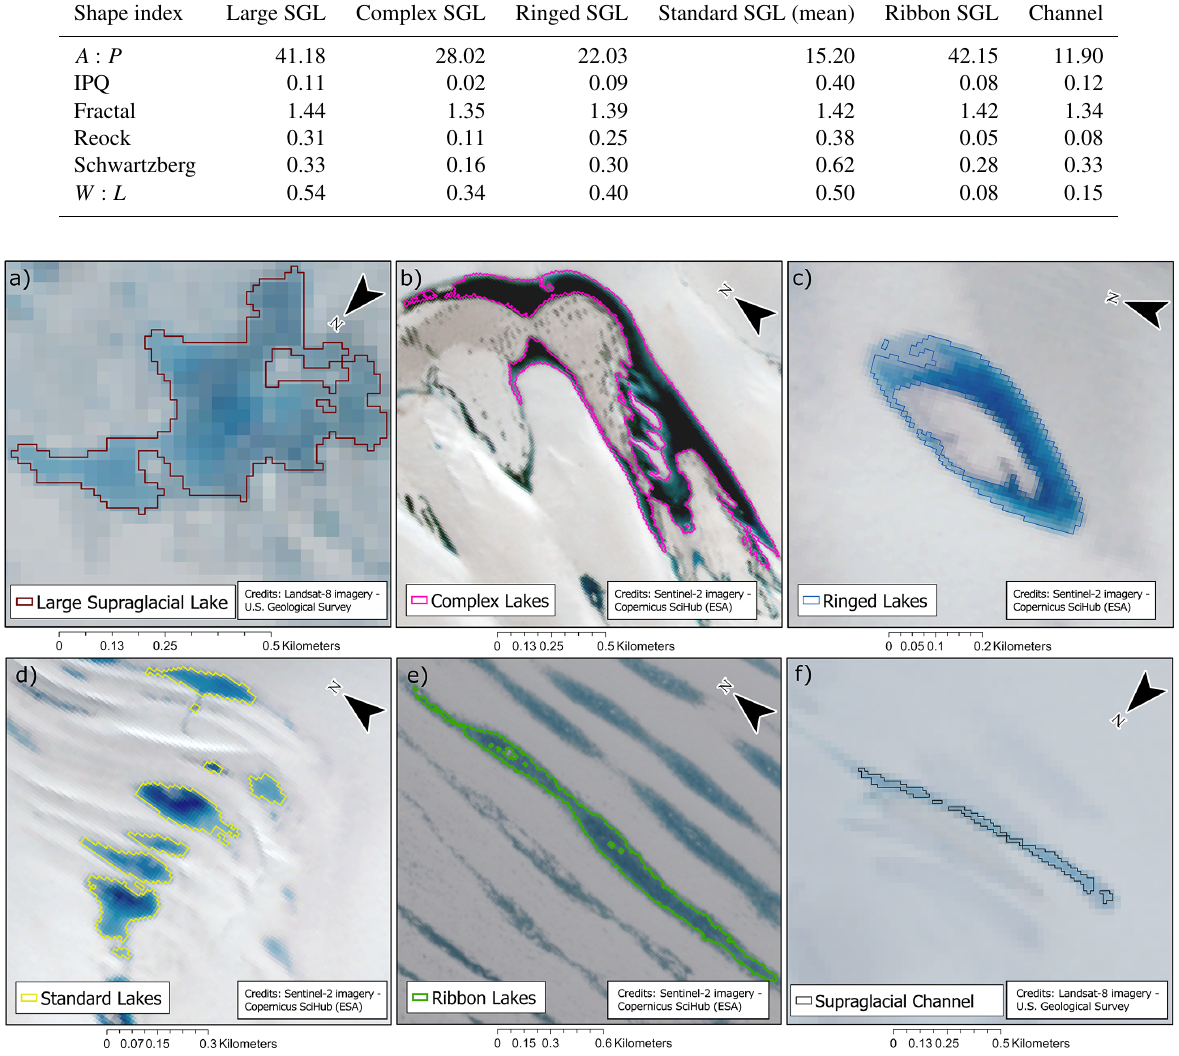
Figure 10. Outlines of supraglacial features over RGB composites from S2 and L8 imagery. These outlines demonstrate six of the distinct clusters from the K-means approach. (a) A large SGL covering 0.20km 2 on Hull Glacier (Fig. 1); (b) complex SGL with area of 0.35km 2 on Bach IS (Fig. 1); (c) ring lake with area of 0.05km 2 on Bach IS; (d) 11 “standard” SGLs on Bach IS with areas ranging from 300m 2 to 0.02km 2 ; (e) ribbon lake on GVI IS (Fig. 1) which spans 2.6km and covers 0.19km 2 ; and (f) discontinuous supraglacial channel span- ning 1.3km and covering 0.04km 2 near Hull Glacier. RGB composites formed from L8 tile LC08_L1GT_022114_20170111 (a, f) from 11 January 2017 and S2 tiles T18DXF_20170129 (b, c, d) from 29 January 2017 and T19DEB_20170103 (e) from 3 January